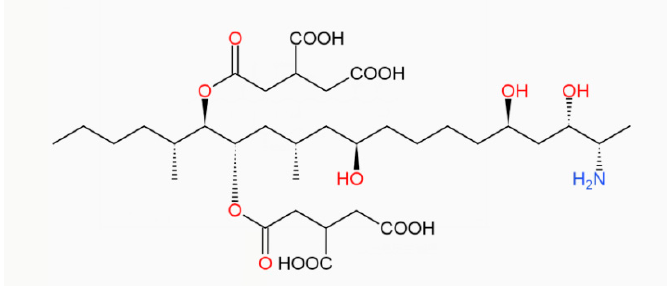
Figure 1. Chemical structure of FB1.